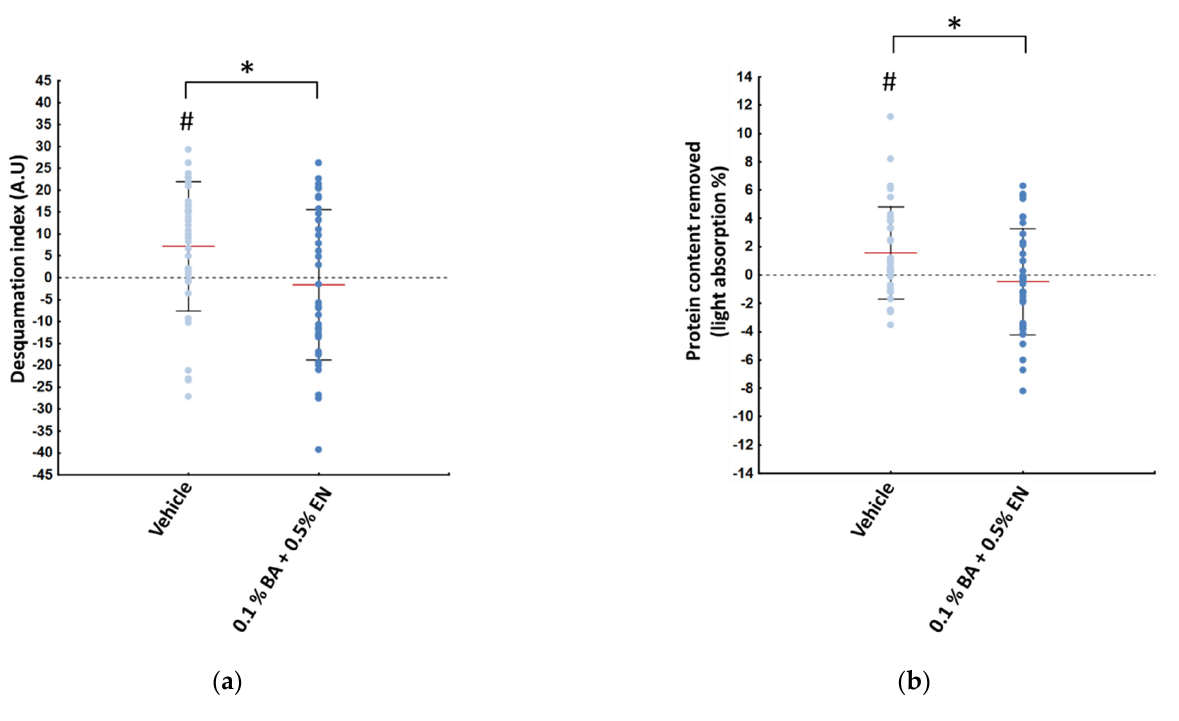
Figure 5. Desquamation index ( a ) and protein content removed from D-squames ( b ) after 28 days of treatment for the vehicle (light blue) and the BA + EN (dark blue) treated sides. * denotes a significant difference between the two treated sides, while # denotes a significant variation versus baseline measurements (paired Student’s t -test, p * ≤ 0.05). Red bars represent mean ± SD in black ( n = 35).